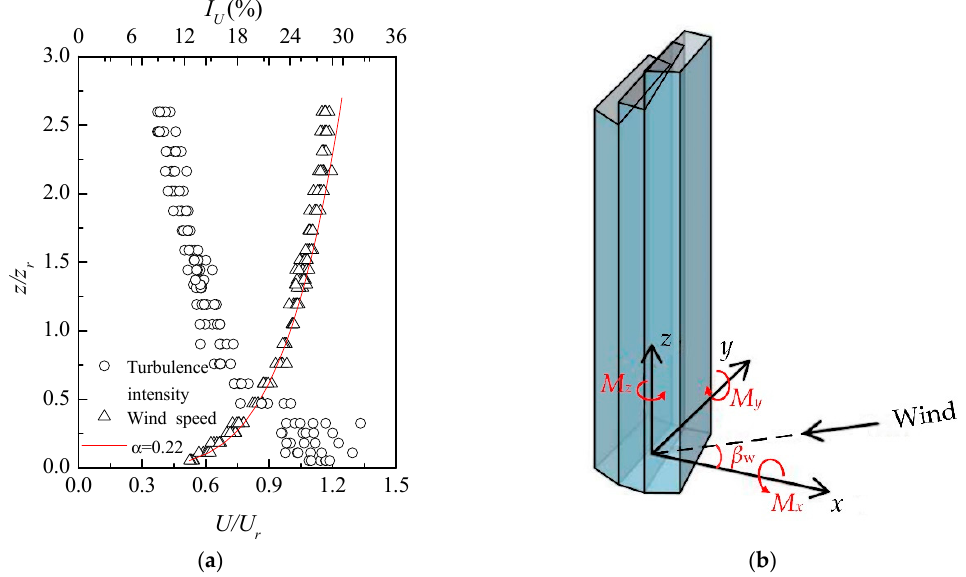
Figure 5. Wind model characteristics: ( a ) wind profile; ( b ) definition of coordinates.